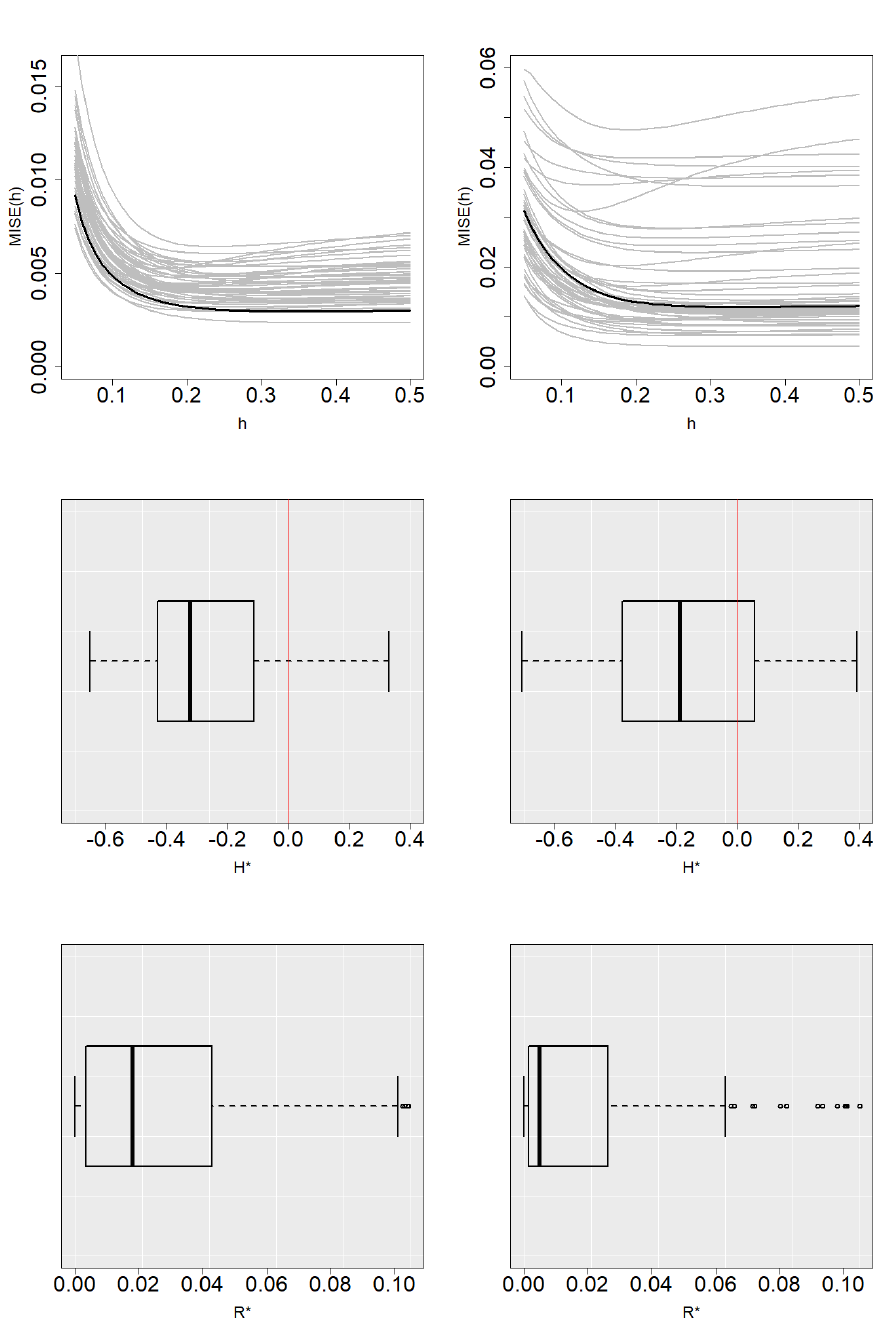
Figure 1. MISE x ( h ) function (black line) approximated via Monte Carlo and MISE ∗ x ( h ) functions (gray lines) for N = 300 samples (textbftop), boxplot of H ∗ R ∗ ,..., R ∗ values ( bottom ) when the conditional probability of censoring is 0.2 ( left ) and 0.5 ( right ) N 1 in Model